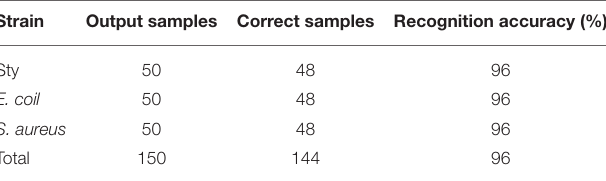
TABLE 5 | Classification results (acidic condition).